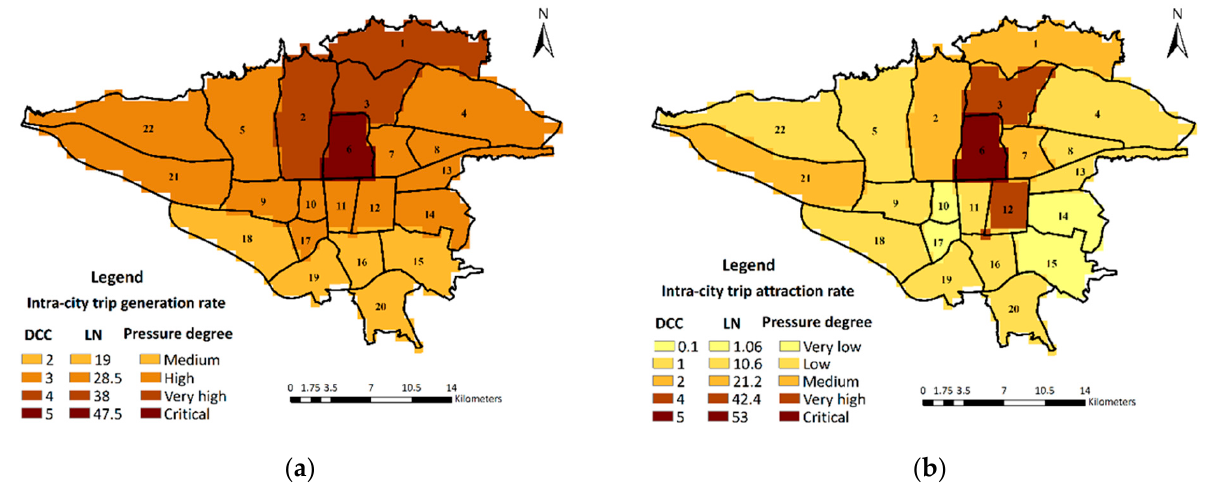
Figure 5. The DCC and LN maps of traffic indicators. ( a ) Trip generation rate; ( b ) trip attraction rate.